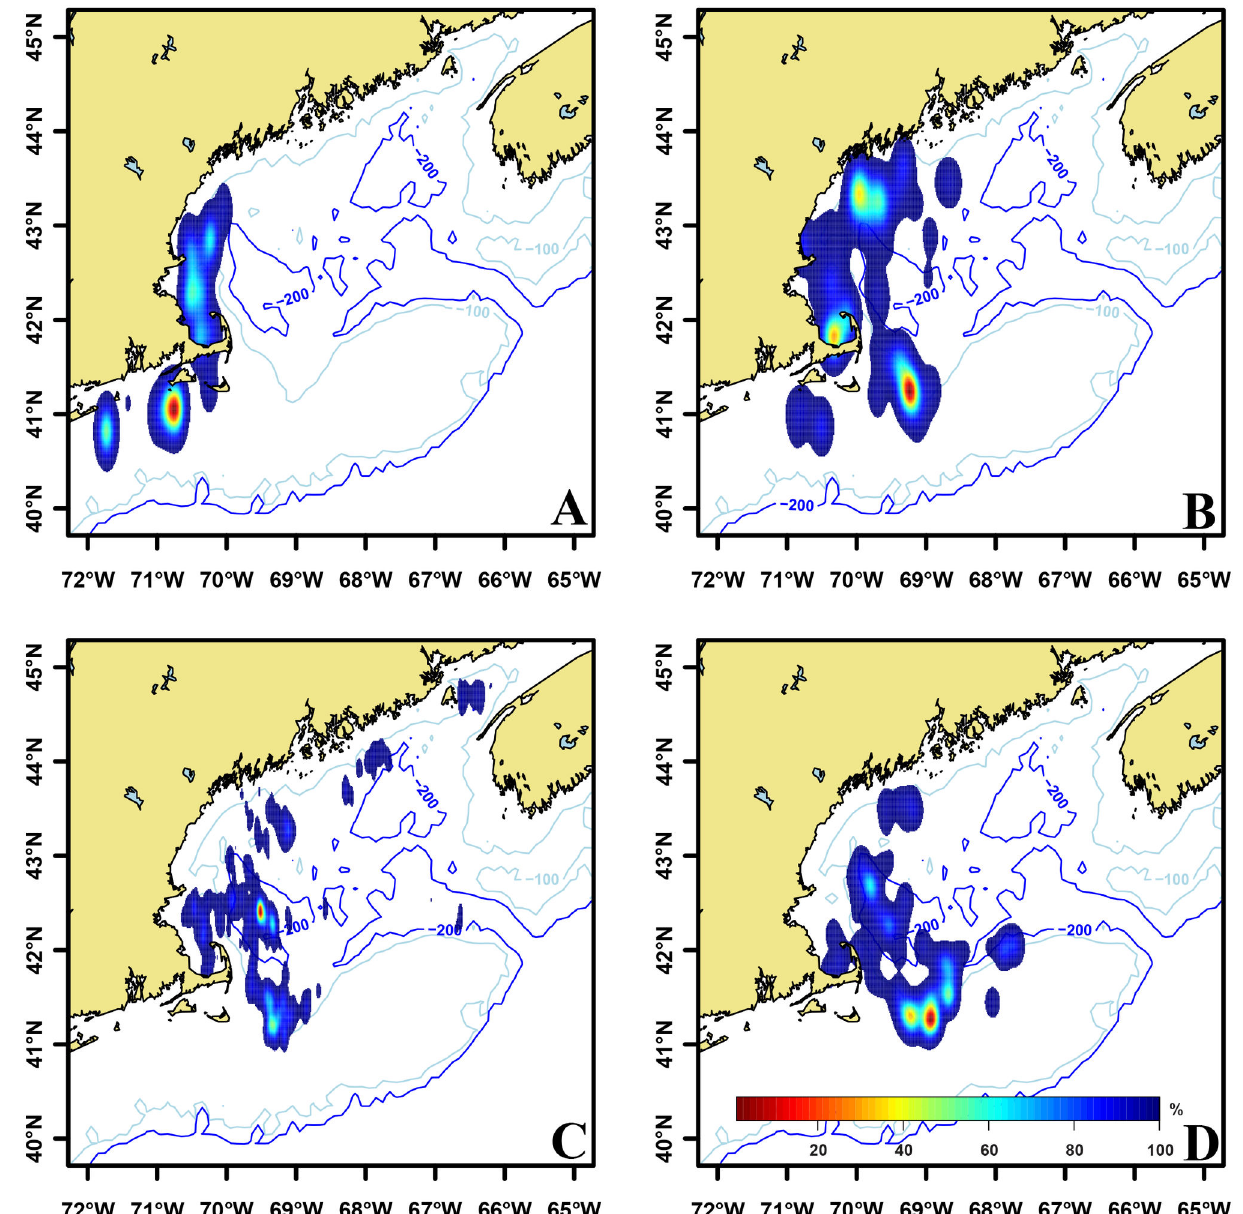
Figure 2. Distribution of Atlantic bluefin tuna in the Gulf of Maine. Kernel density estimations were constructed based on the number of fish observed in each school over four selected time periods. Density estimations were normalized yielding utilization distributions that displayed probability of occurrence during four time periods, A) 1979-1985, B) 1986-1992, C) 1993-1999, and